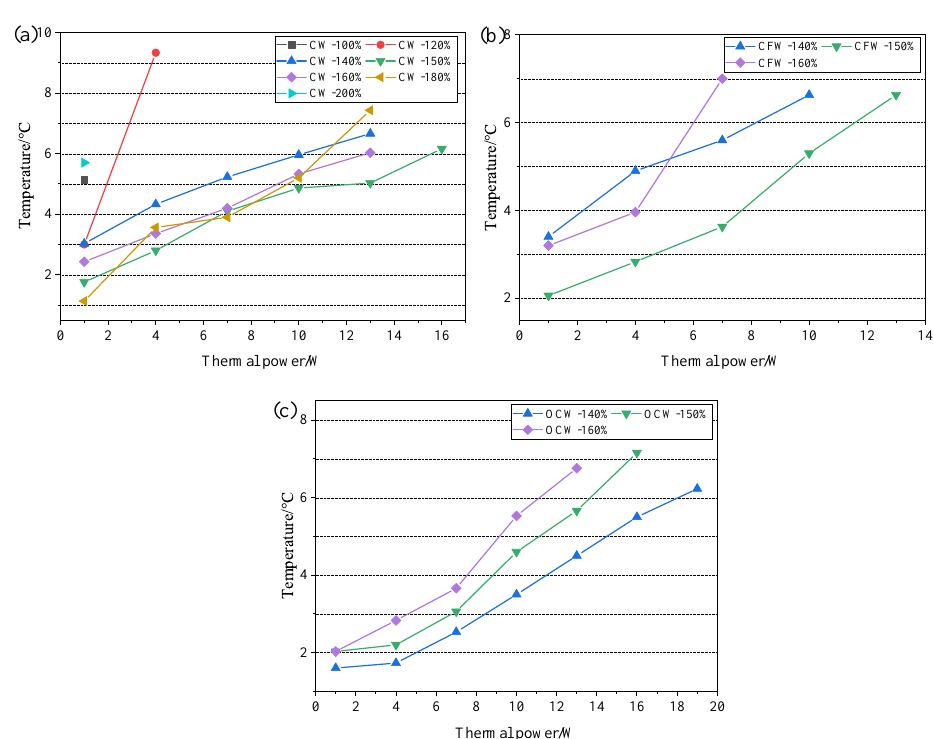
Figure 9. Temperature difference of FMHP under different thermal power. ( a ) CW-FMHP; ( b ) CFW- FMHP; ( c ) OCW-FMHP.